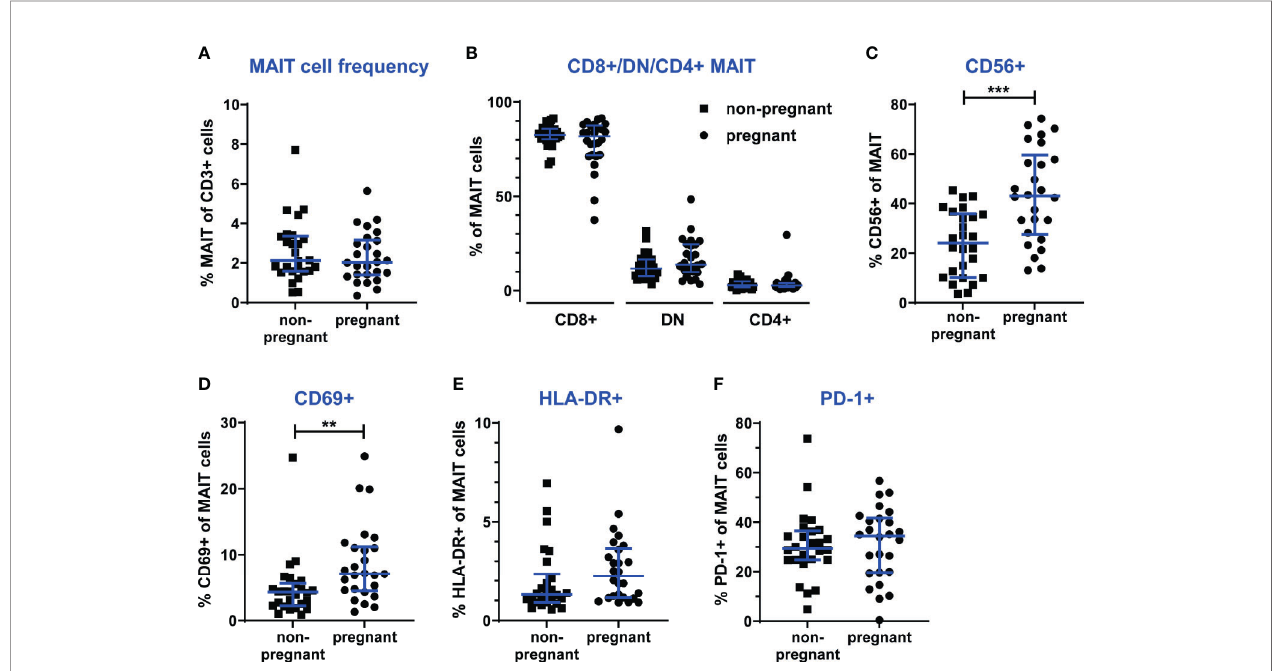
FIGURE 4 | The frequency and phenotype of circulating MAIT cells are unaltered during the 3 rd trimester of pregnancy, but in pregnant women more MAIT cells express the activation marker CD69. PBMCs from women pregnant in the 3 rd trimester (n=26) and from non-pregnant, age-matched controls (n=26) were analyzed by fl ow cytometry for MAIT cells frequencies, MAIT cell subsets and the expression of activation markers. (A) MAIT cells numbers were analyzed using a gating strategy similar to the one shown in Figure 1A (live CD3 + V a 7.2 + CD161 hi cells). (B) Proportions of CD8 + , CD4 + and double-negative (DN) subsets of MAIT cells. (C) Proportions of the CD56 + subset of MAIT cells. Cell surface expression of the activation markers (D) CD69, (E) HLA-DR and (F) PD-1. Bars show median and IQR and statistical comparisons were performed using Mann-Whitney test. ** p < 0.01, *** p <